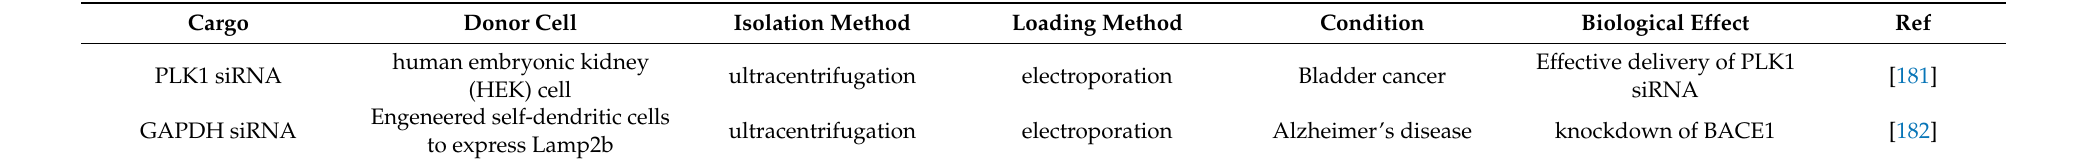
Table 3. Summary of studies conducted on siRNA as a cargo of